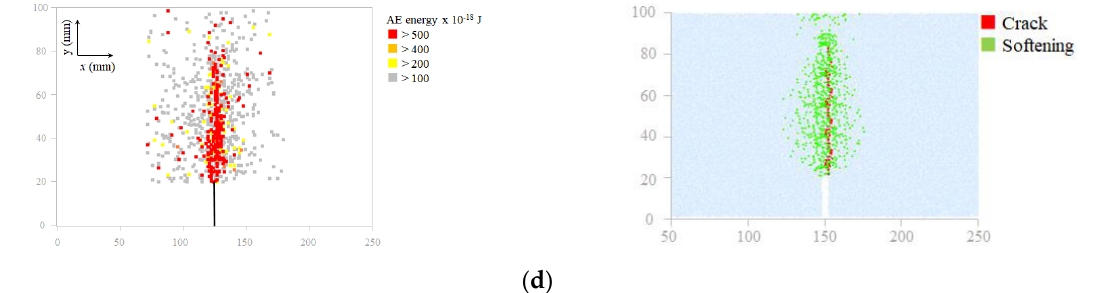
Figure 16. Comparison of AE results and simulation results in the center section of the beam: ( a ) Point A (peak force); ( b ) Point B (post-80% of peak force); ( c ) Point C (post-60% of peak force); ( d ) Point D (post-40% of peak force).